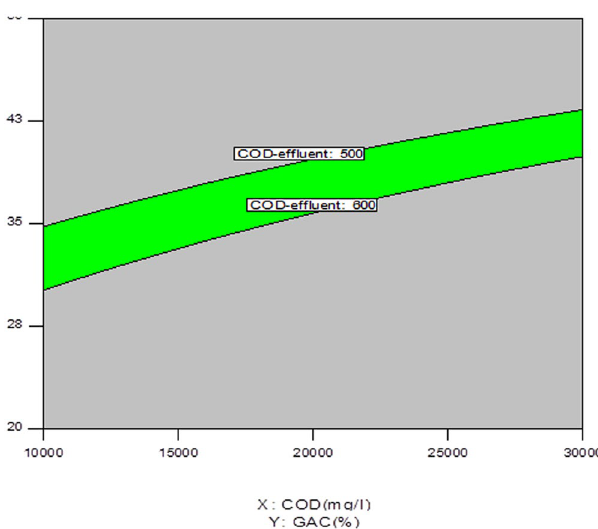
used for discharging MLL effluent to municipal wastewater network. The optimum zone was obtained based on responses of COD in the range 500–600 mg/L and BOD in the range 200–300 mg/L. Figure 6 illustrates the achieved optimum zone.